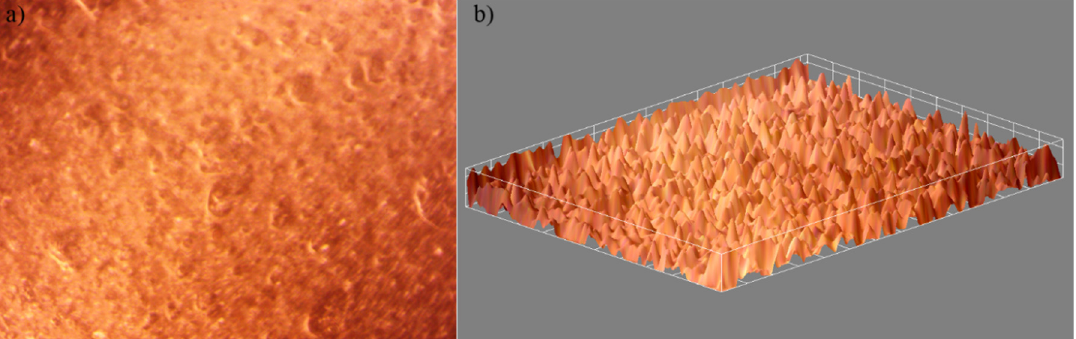
Figure 14. Metallographic microcopy image of the 25MgHAp coating surface ( a ) and 3D representation of the surface of the 25MgHAp coatings ( b ).